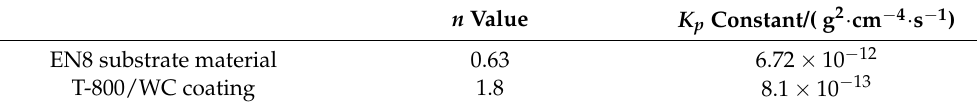
Table 2. Kp constants for EN8 and T-800/WC.